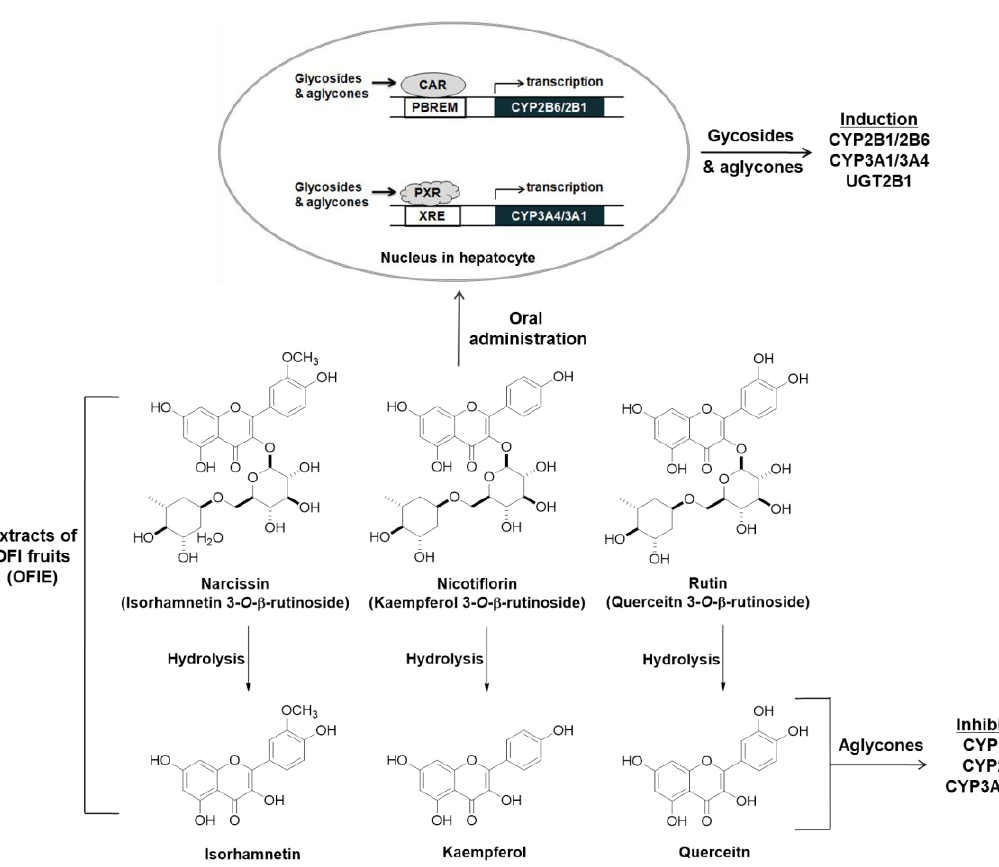
Figure 6. A scheme for the induction and inhibition of hepatic drug metabolizing enzymes (DMEs) by Opuntia ficus indica fruit extract (OFIE) and the related mechanisms. Narcissin, nicotiflorin, and rutin are glycosides, whereas isorhamnetin, kaempferol, and quercetin belong to the flavonol aglycone. Both glycosides and aglycones are involved in the induction of the expression of some CYPs and UGTs; on the other hands, only aglycones seem responsible for CYP inhibition.